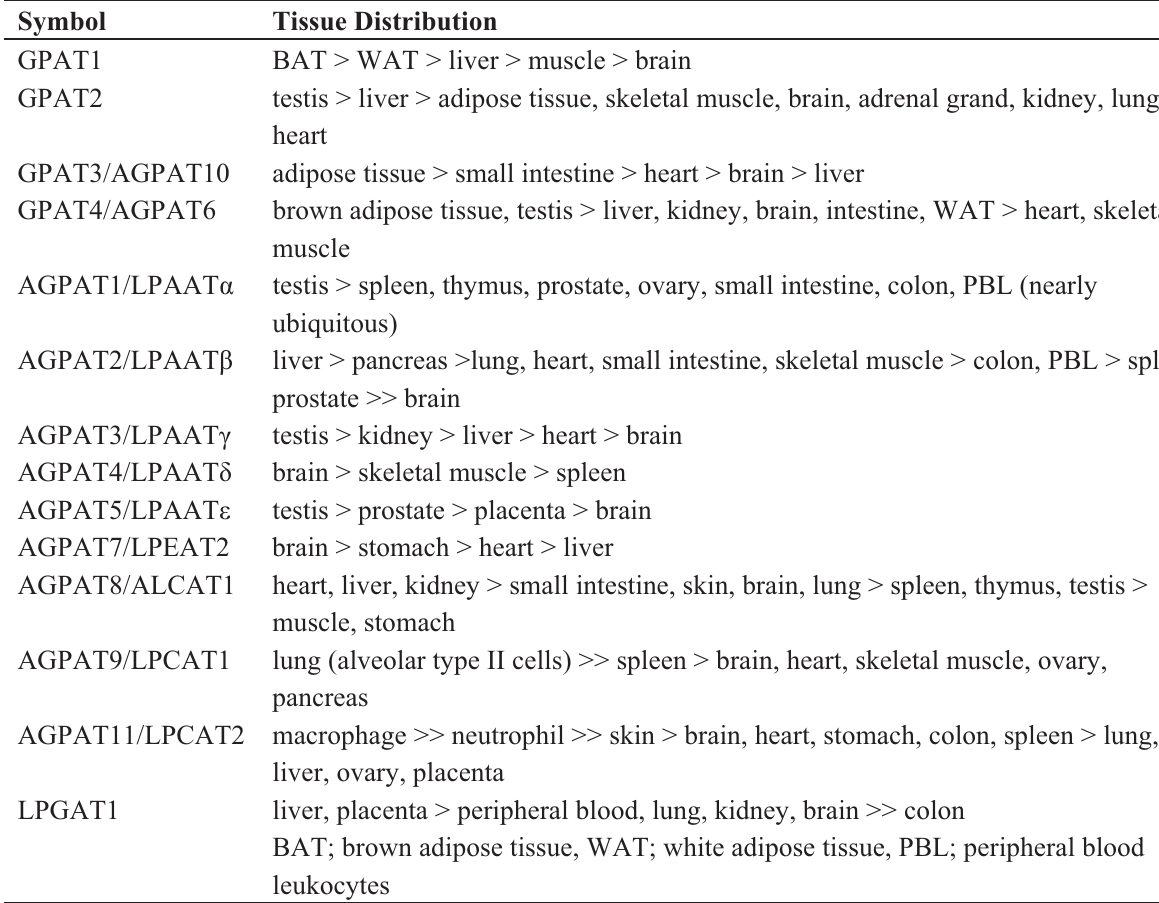
Table 2. Tissue distribution of GPAT/AGPAT family